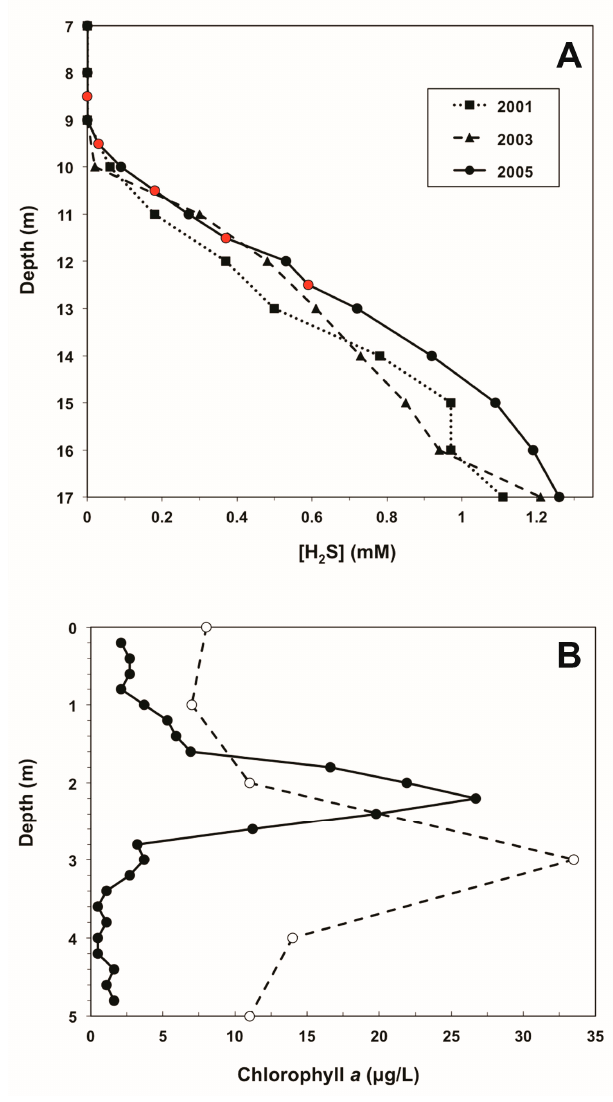
Figure 5. Field results using the pump-driven water sampler. ( A ) Comparison of sulfide concentrations in meromictic Lake Fryxell, Antarctica from samples obtained using a Niskin bottle (2001 and 2003) versus the pump-driven sampler (2005). A general consistency in the concentrations in each profile, as well as the especially smooth curve from the 2005 samples, shows the accurate and precise performance of the new sampler. Data points in red indicate samples taken in 0.5-m increments through the biologically dynamic chemocline of the lake, thus providing a sampling resolution not possible with the Niskin bottle. ( B ) Comparison of Chl a concentrations in the water column of Little Crooked Lake, Indiana, from samples obtained using a Van Dorn sampler (dashed line, adapted from [14]) with those obtained using the pump-driven sampler (solid line). Sampling dates for ( B ): 19 July 1982 [14]; 19 June 2017 [this study].